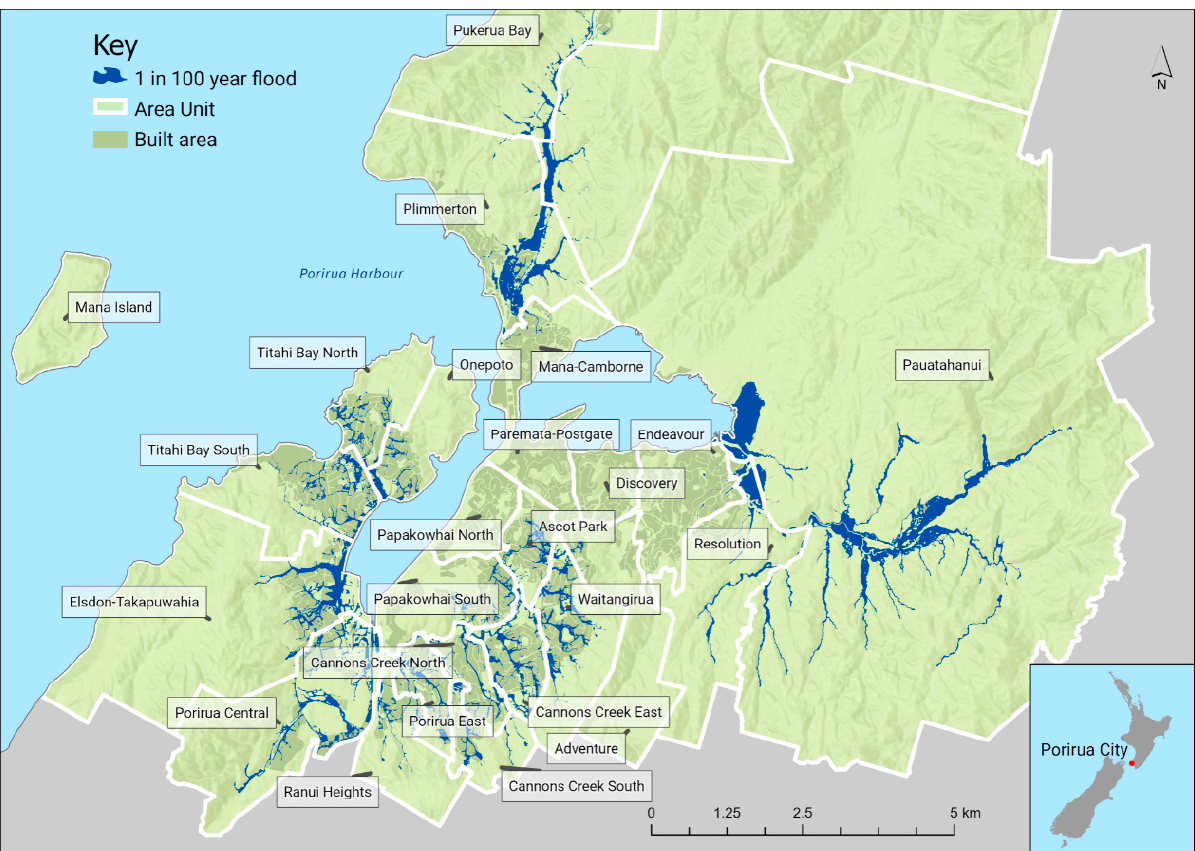
Figure 1. Map of Porirua City, with flood hazard zones and 2013 area unit boundaries. Note: Flood hazard zones give the flood hazard for a 1-in-100 year flood event. These hazard zones account for 100 year climate change impacts, in terms of sea level risk and increased rainfall. The models have used 1 metre sea-level rise and a 20% increased rainfall. The models were prepared by Wellington Water. Sources: ESRI, NASA, NGA, USGS, OpenStreetMap, Statistics New Zealand, Wellington Water, Porirua City Council.